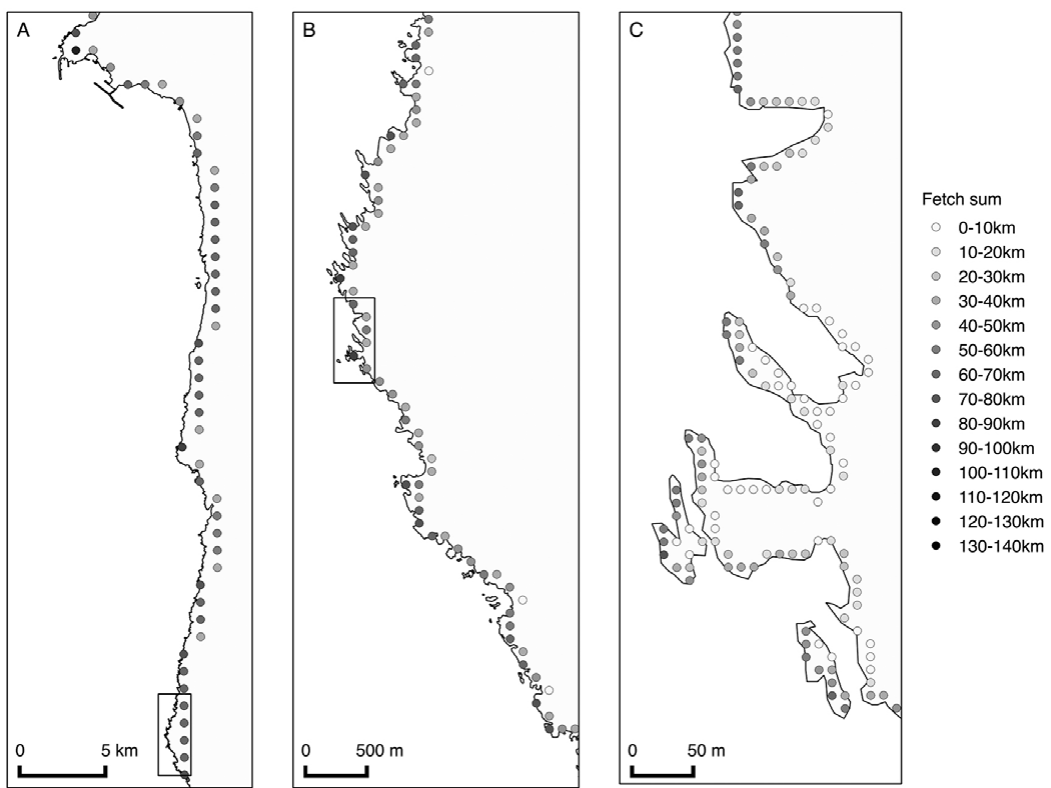
Fig. 2. – Examples of fetch estimates (FeEx ) for coastal cells at different spatial scales (A, B and C represent the 1 km, 100 m and 10 m sum resolutions, respectively; boxes in A and B represent the extents of B and C,